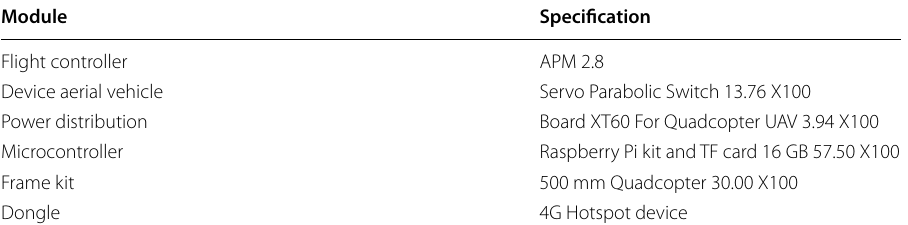
Table 3 UAV specifications